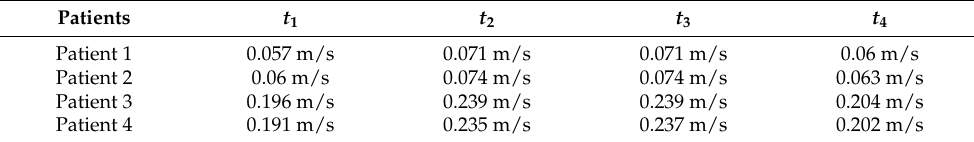
Table 2. Exact values of the inlet velocity for each